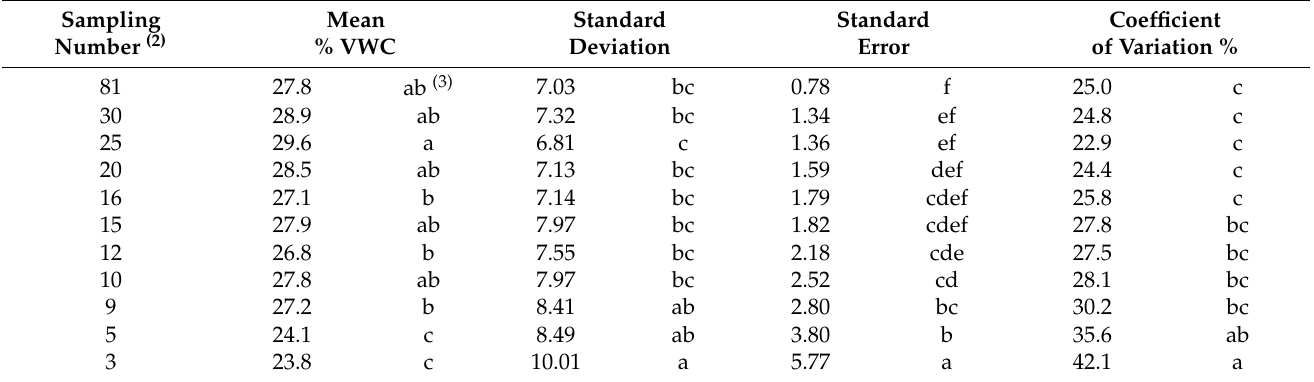
Table 2. Statistical analysis of VWC (volumetric water content) sampling data from the study site (1)